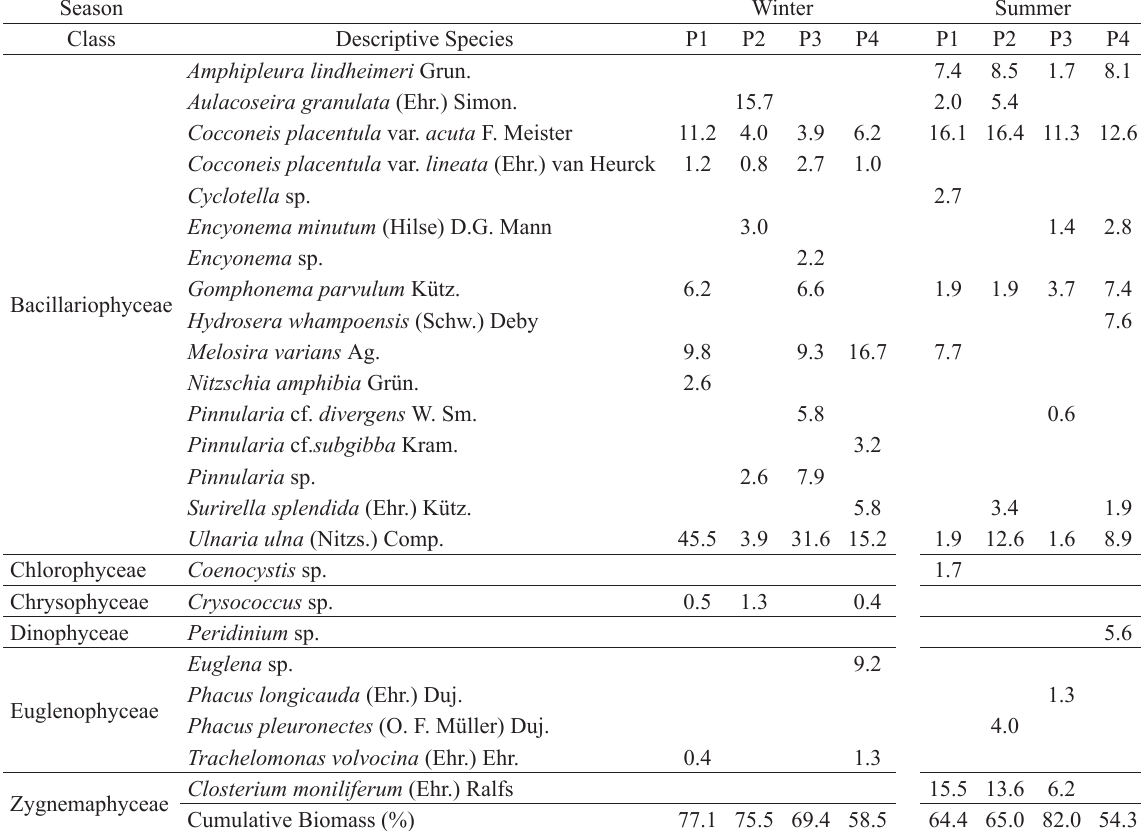
Relative biomass of descriptive species in sampling points (P1 = most preserved; P4 = less preserved), in winter and